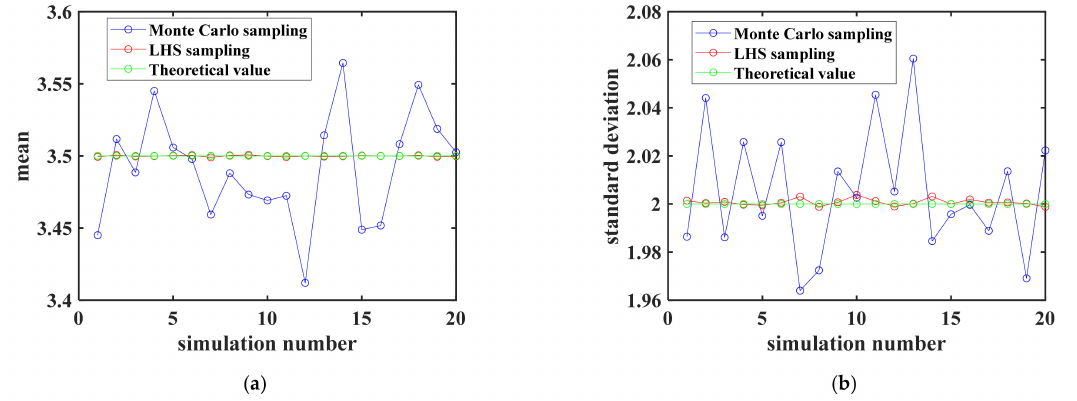
Figure 5. Fluctuation chart of ( a ) mean and ( b ) standard deviation of the